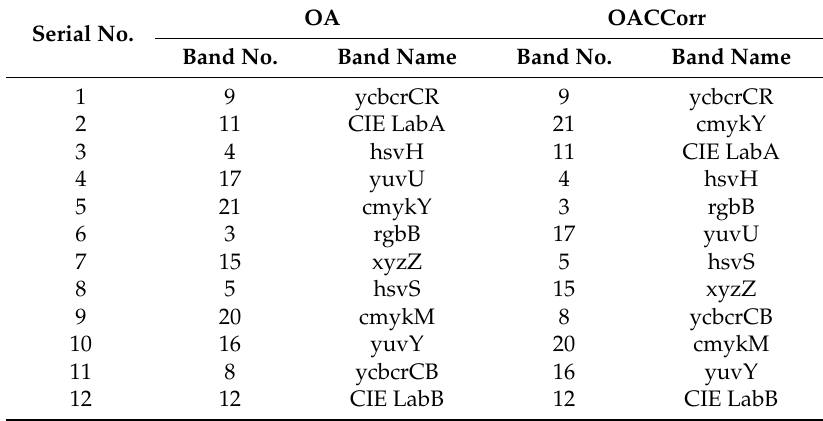
Table 1. Comparison of overlapping area with overlapping area and cross-correlation method. OA OACCorr Serial No. Band